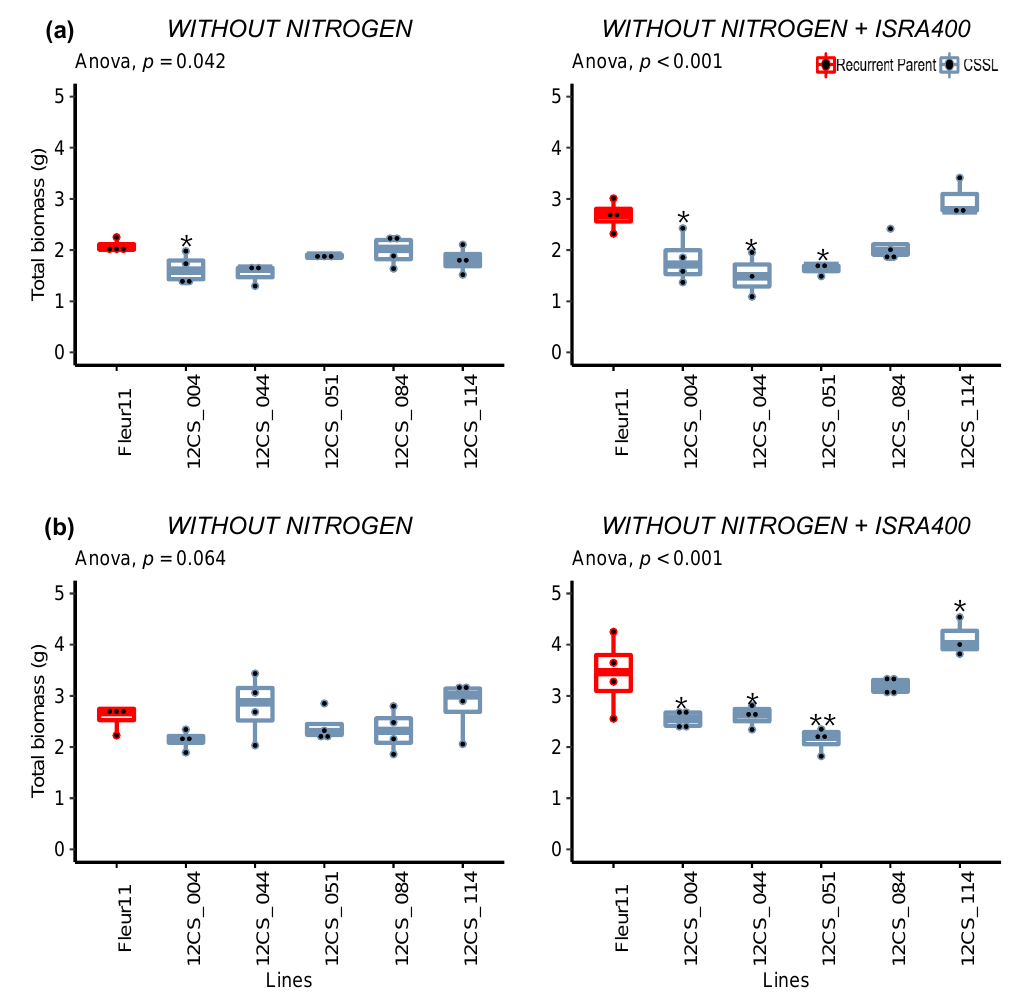
Figure 3. Variation in total biomass 35 days after inoculation under controlled conditions. ( a , b ): First and second experiments, respectively. Without nitrogen and without nitrogen + ISRA400 indicate uninoculated plants (negative control) and plants inoculated with B. vignae ISRA400, respectively. * and ** indicate values significant at p < 0.05 and p < 0.01, respectively, using Dunnett’s multiple comparisons test.